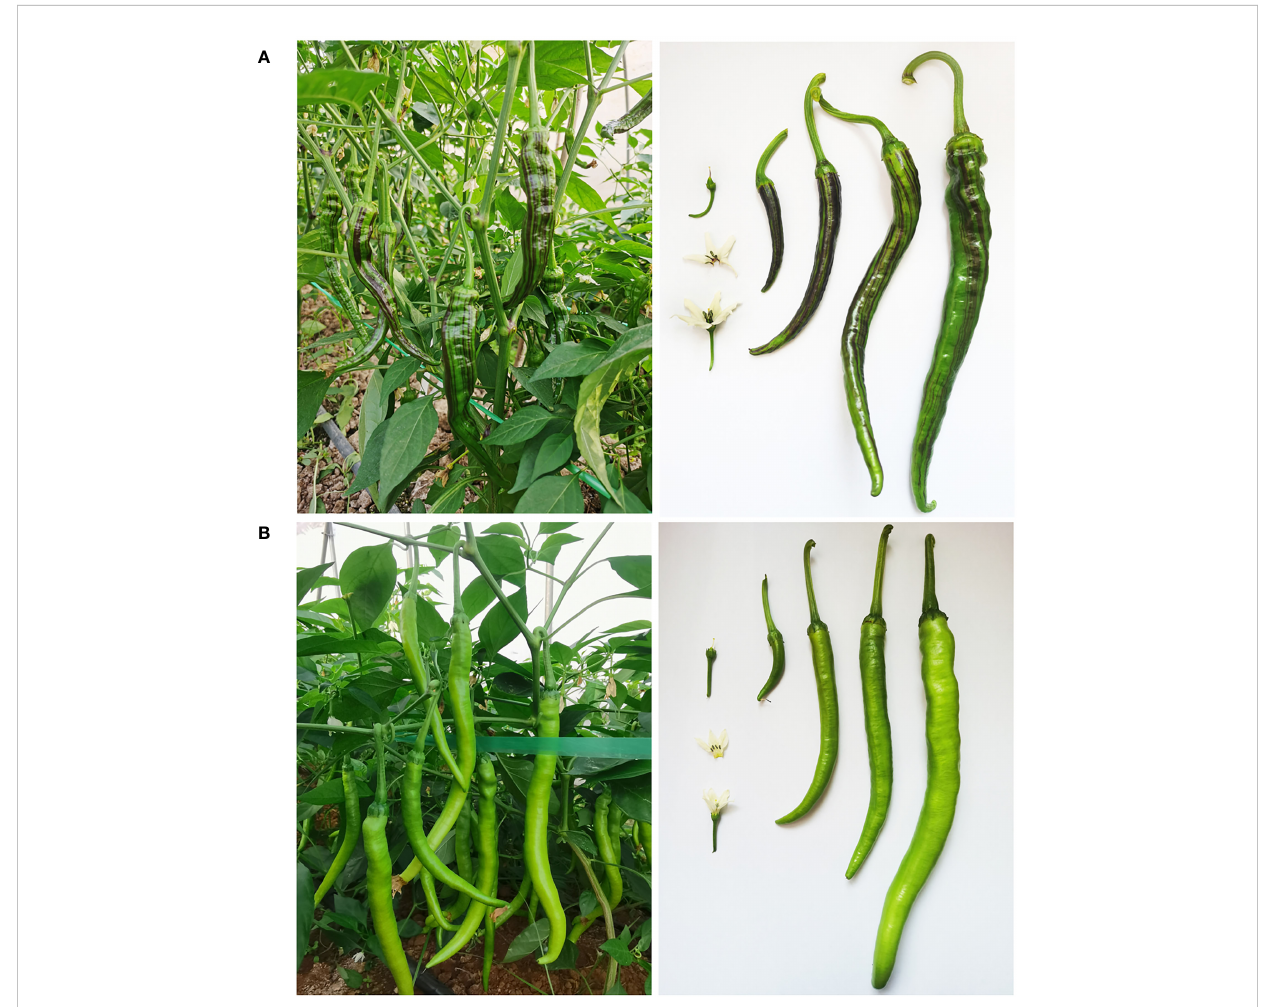
FIGURE 1 Phenotype of two parents. (A) The plants, fruits and fl owers of Chen12-4. (B) The plants, fruits and fl owers of